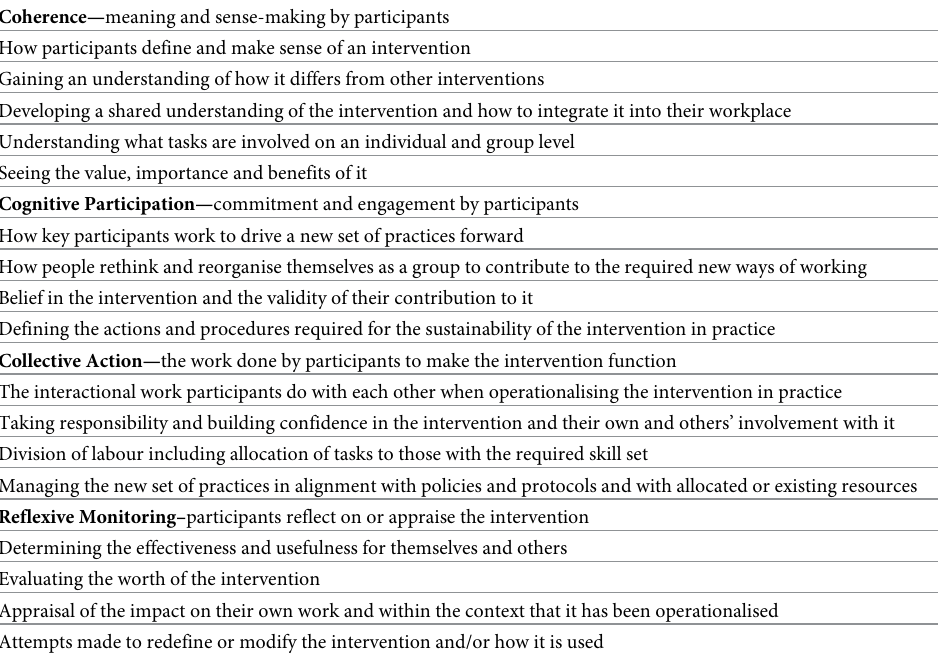
Table 2. Components of the four Normalisation Process Theory constructs [18, 20–22]. Coherence— meaning and sense-making by